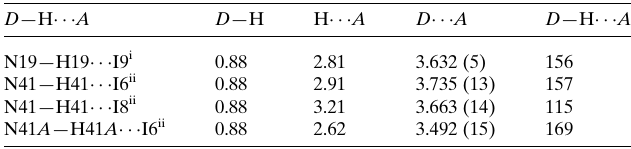
Table 1 Hydrogen-bond geometry (A˚ , (cid:3)